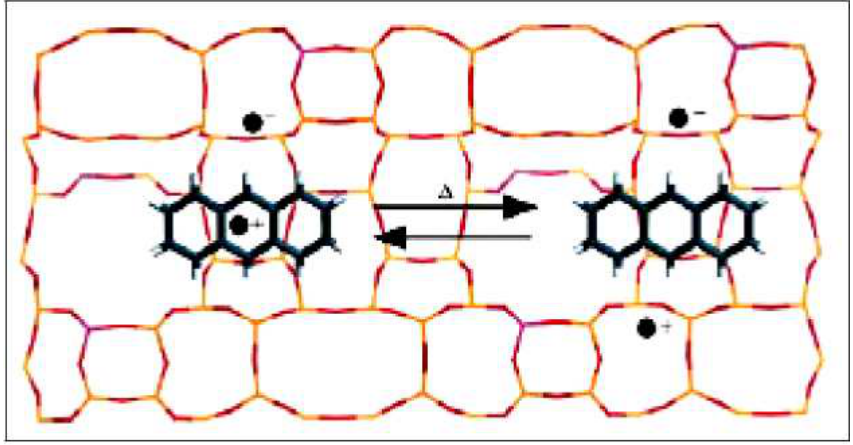
Figure 1. Schematic structure of radical cation 6 inside a